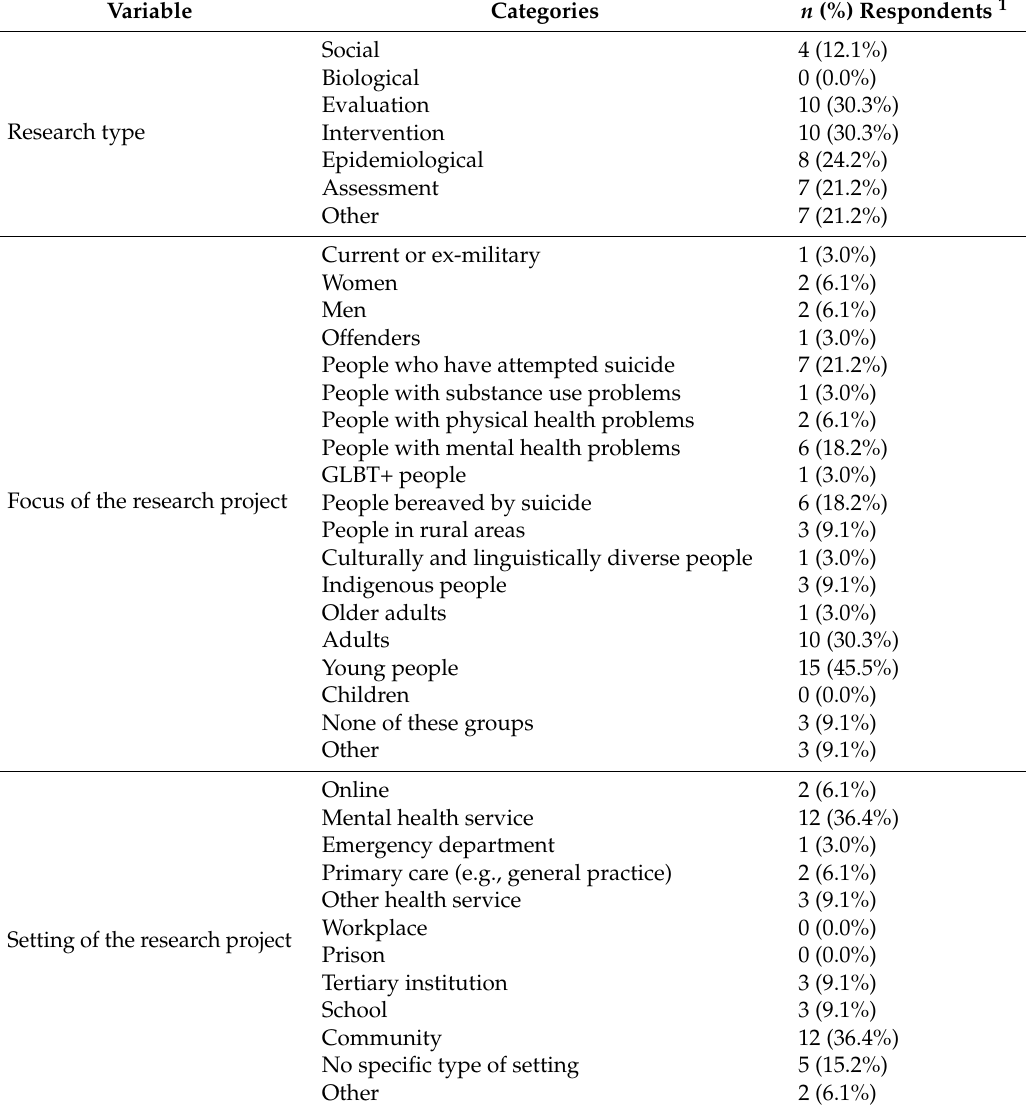
Table 2. Characteristics of specific ethics